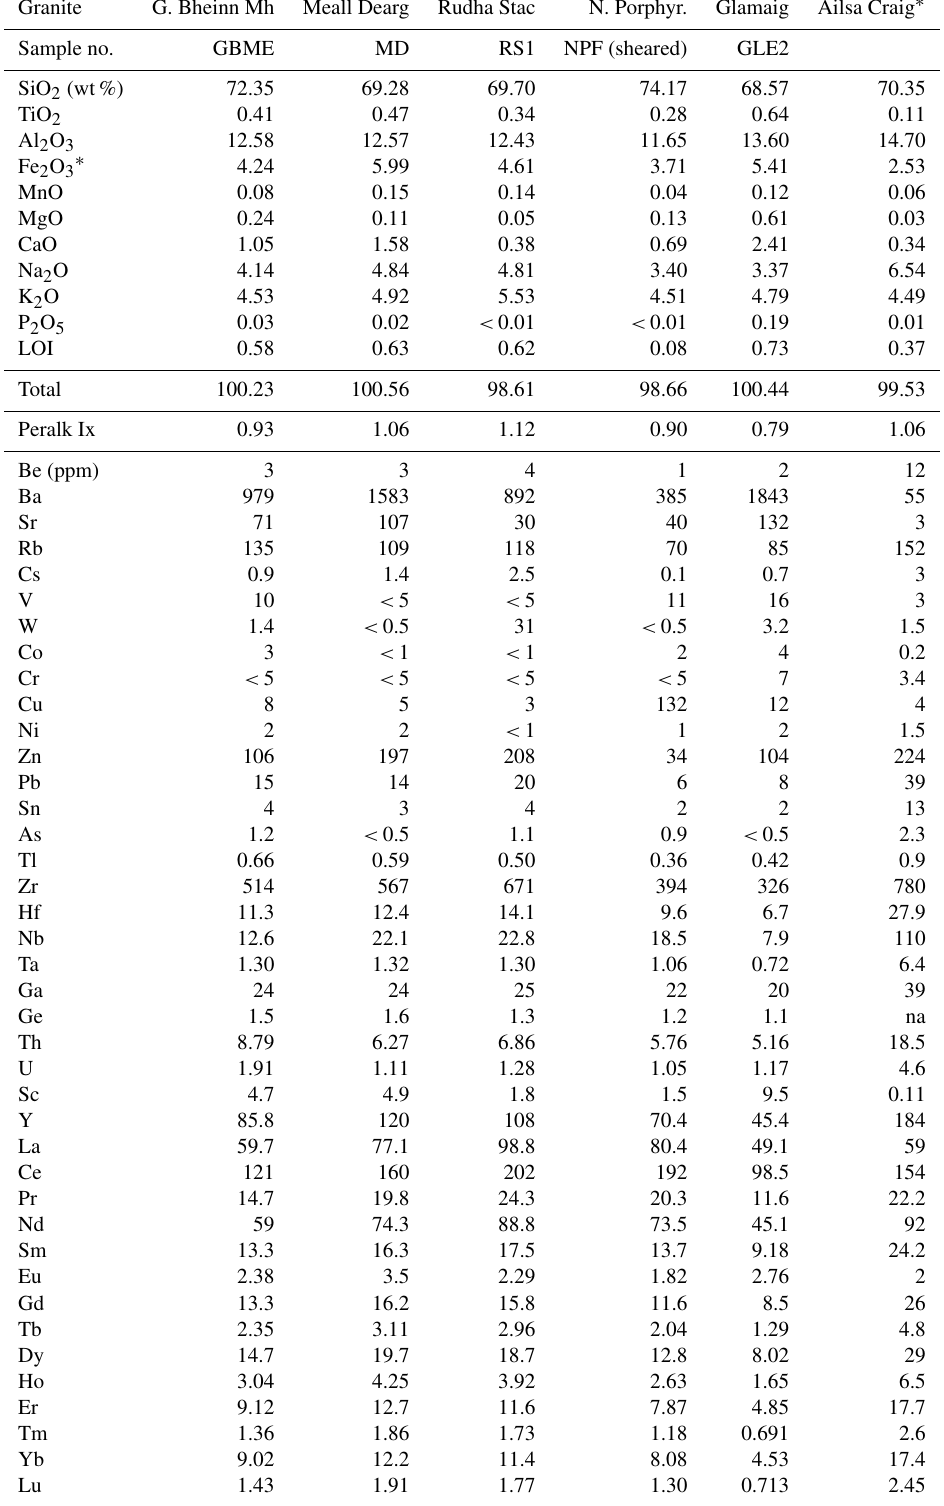
Table 2. Chemical compositions of selected granites with Ailsa Craig. Granite G. Bheinn Mh Meall Dearg Rudha Stac N. Porphyr. Sample no.